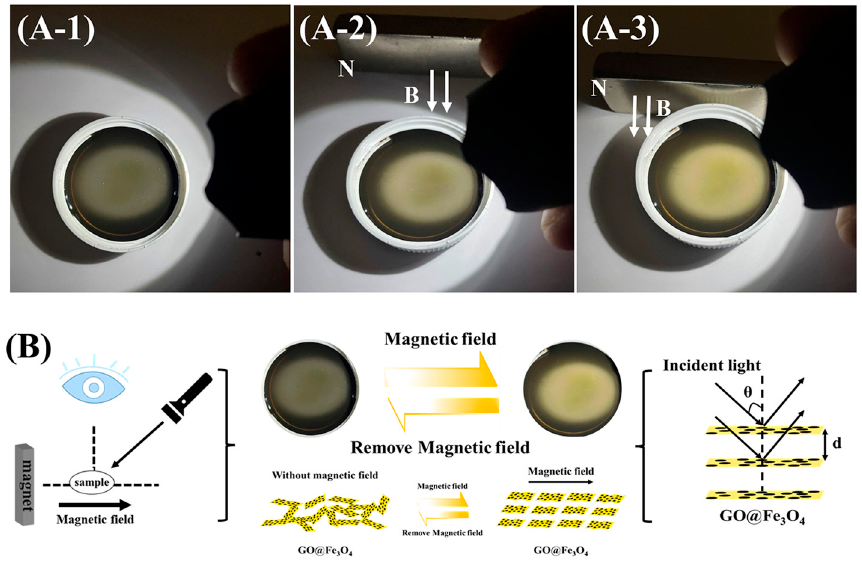
Figure 14. ( A-1 – A-3 ) Real images of the Bragg reflections of GO@Fe 3 O 4 sol under various magnetic field strengths and ( B ) Schematic diagram of the orientation of GO@Fe 3 O 4 nanoflakes and the formation of Bragg reflections. ( A-1 ) without magnet; ( A-2 ) the distance between the sample and magnet was 2 cm; ( A-3 ) the distance between the sample and magnet was 0.2 cm. (The B shows the direction of the magnetic field).